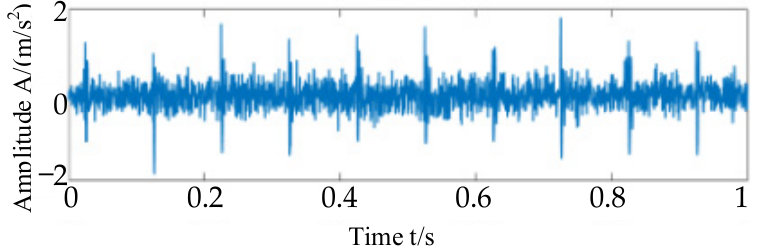
Figure 5. Filtered signal time-domain waveform. Table 3. Sparse representation coefficients of different atoms.